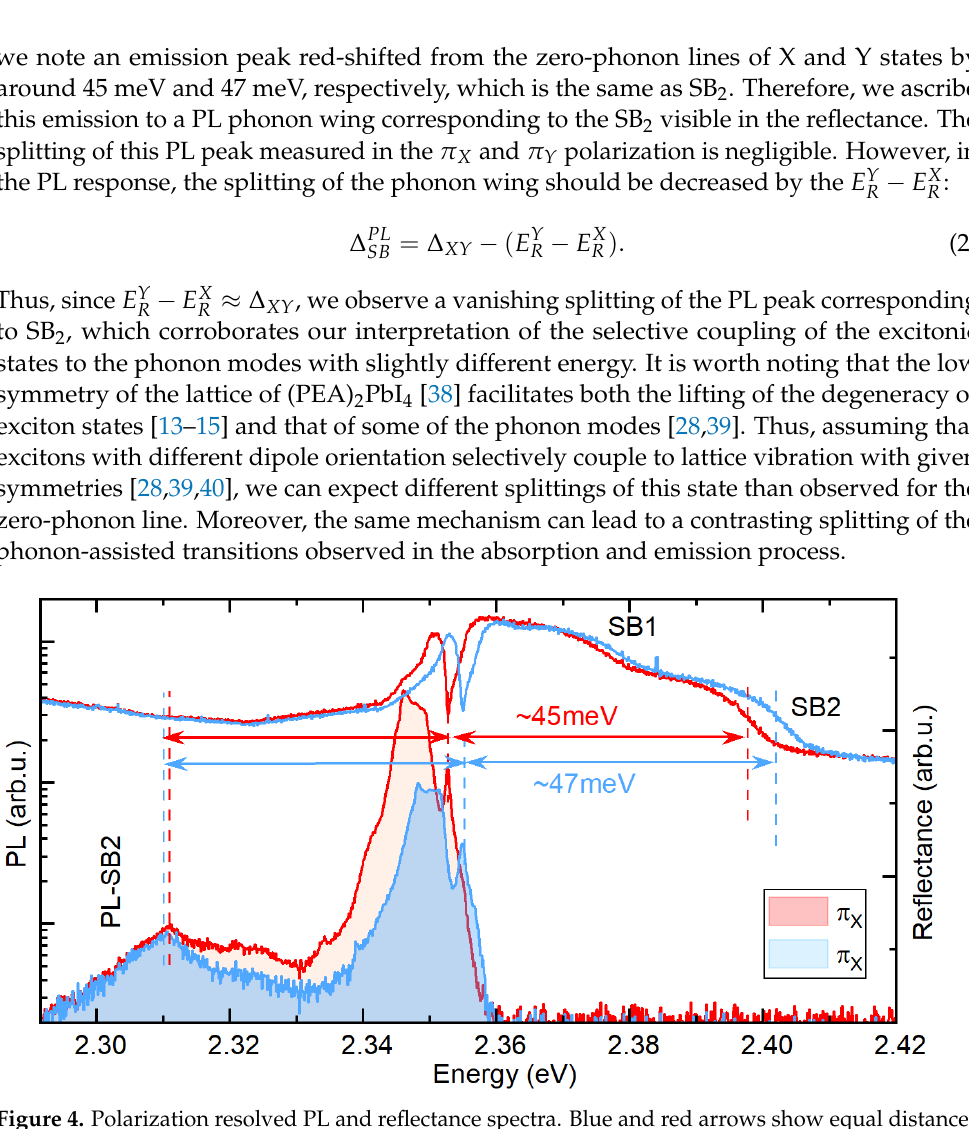
Figure 4. Polarization resolved PL and reflectance spectra. Blue and red arrows show equal distances of low energy PL peak and SB2 from the zero-phonon line of X and Y